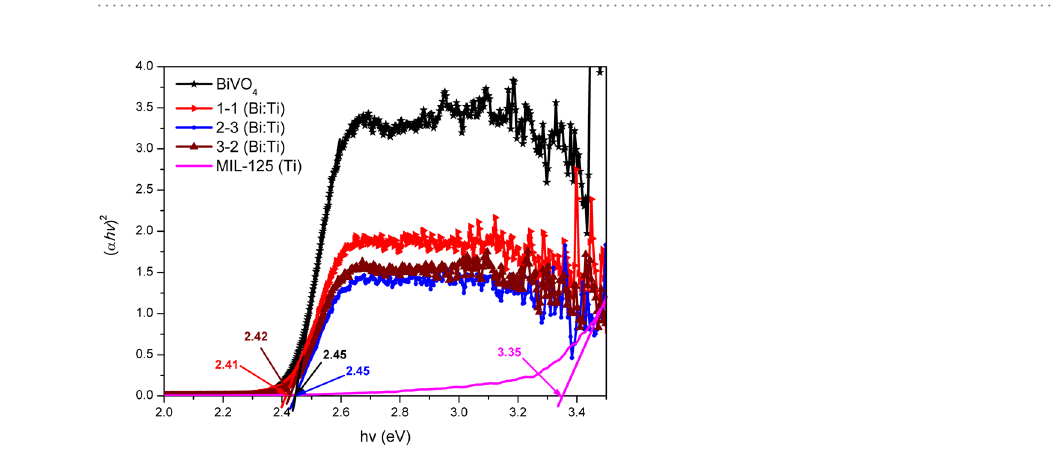
Figure 6. Tauc plots of the synthesized